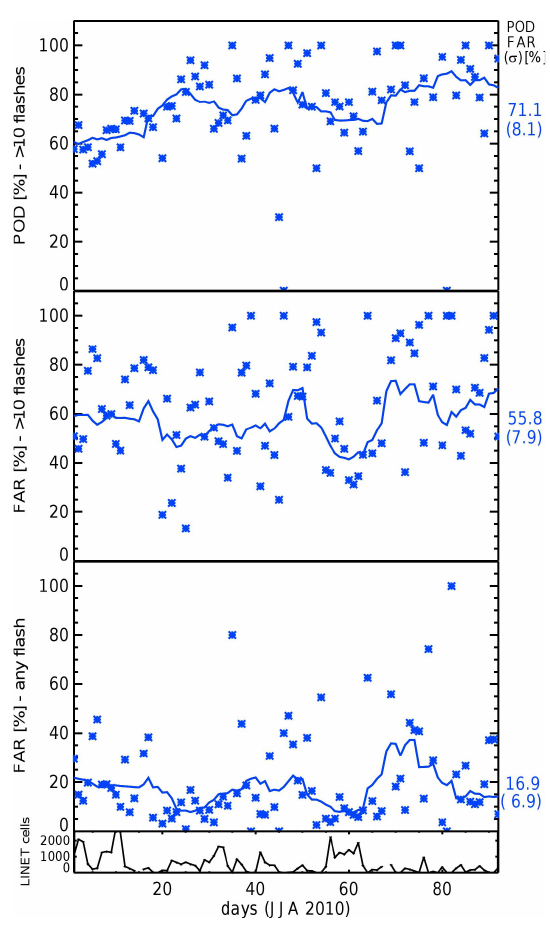
Fig. 6. Top: POD for a lightning cell of severe activity ( > 10flashespixel − 1 15min − 1 ) which is detected by a Cb-TRAM object in contact . Shown are the day-to-day values as symbols and the moving average over all evaluated objects within 11 days as well as the mean and standard deviation of the 11-day average to the right of the image (all values in percent). Centre: FAR of Cb-TRAM ob- jects which have no lightning cell showing intense activity in direct contact . Bottom: FAR of Cb-TRAM objects which do not have at least some lightning activity at all in direct contact . Very bottom: number of analysed lightning cells on which the skill scores are